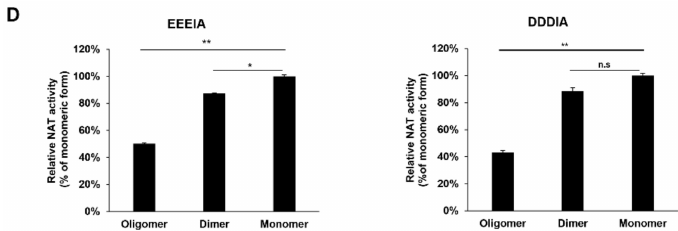
Figure 2. hARD1 / NAA10 forms high-order aggregates during purification. ( A ) Scheme of large-scale purification of hARD1 / NAA10. Lysates from harvested cells were loaded onto a Ni-NTA column, and then subjected to anion-exchange purification with HiTrap Q HP column and size-exclusion chromatography, as described in Materials and Methods. ( B ) Oligomeric status of His-hARD1 / NAA10 recombinants from eluted a ffi nity fractions and anion exchange fractions are examined with size-exclusion chromatography. ( C ) Highly oligomeric His-hARD1 / NAA10 loses its KAT activity. KAT activities of various oligomeric forms of His-hARD1 / NAA10 were measured using the oligomeric forms of eluted hARD1 / NAA10 in the in vitro acetylation assay at indicated time points. Acetylation levels of Hsp70 and hARD1 / NAA10 were assessed with western blotting. ( D ) The NAT activity of di ff erent oligomeric forms of hARD1 / NAA10. (Left) Di ff erent oligomeric states of His-hARD1 / NAA10 were subjected to in vitro N-terminal acetylation assay using EEEIA peptide representing N-teminus of γ -actin. The activity of monomer form is defined as 100%. (Right) Di ff erent oligomeric states of His-hARD1 / NAA10 were subjected to in vitro N-terminal acetylation assay using DDDIA peptide representing N-teminus of β -actin. The activity of monomer form is defined as 100%. The experiments were performed in triplicate. The error bar indicates S.E.M. * p < 0.05; ** p < 0.01; n.s: not